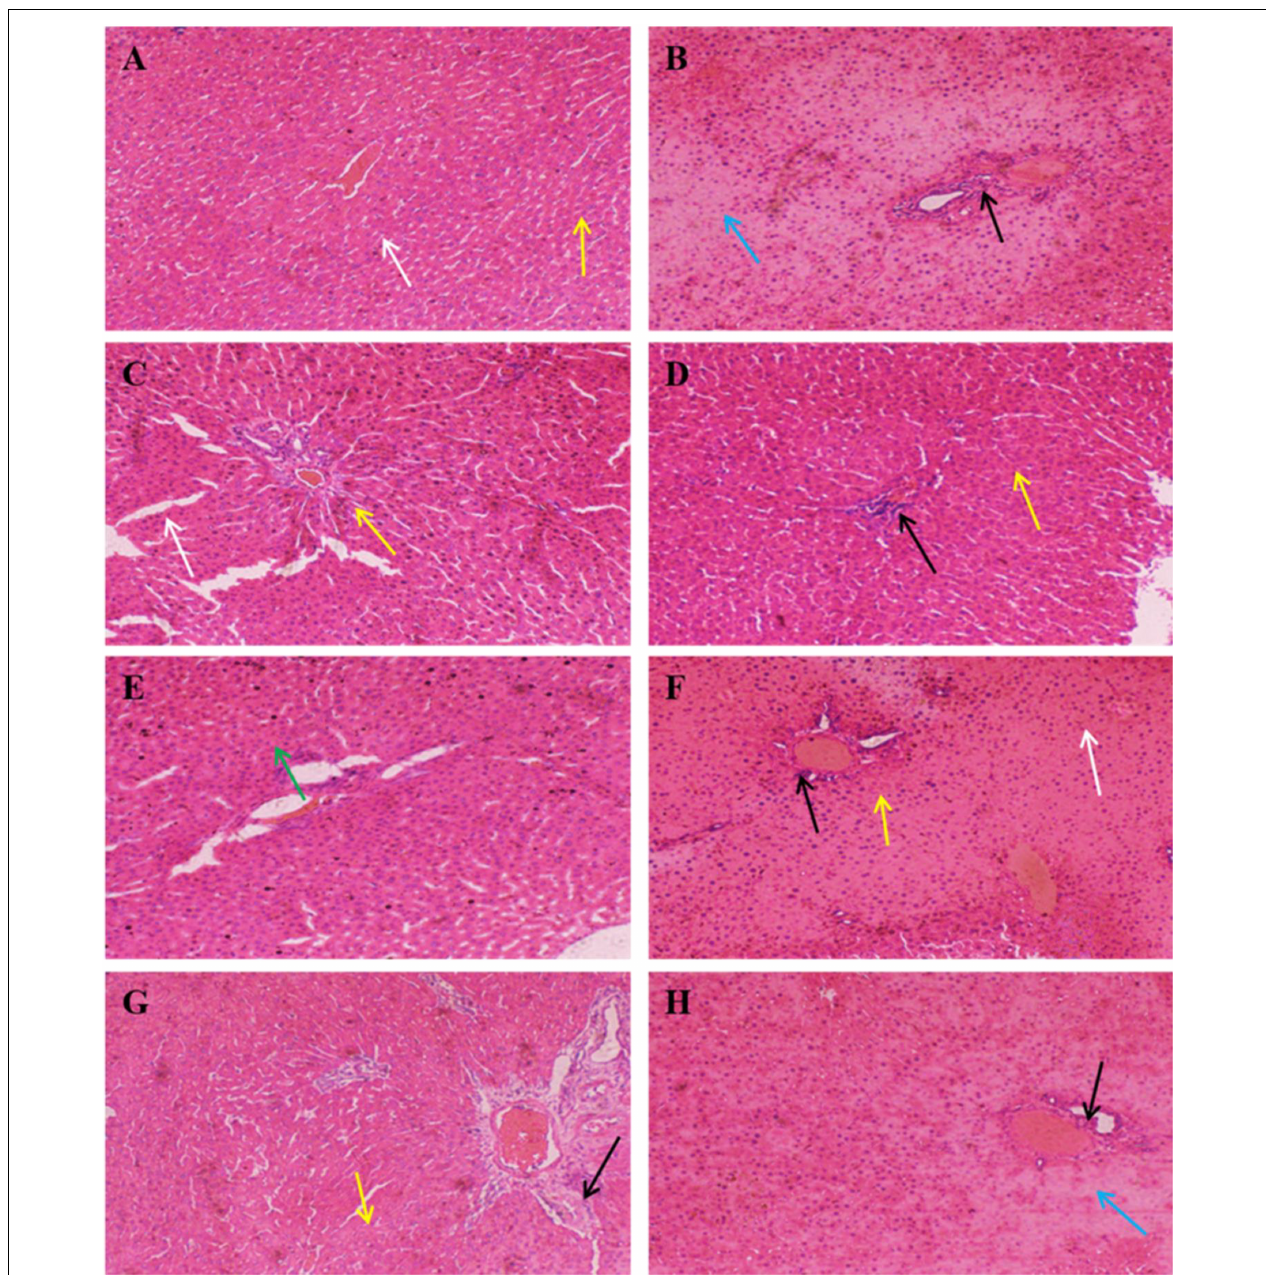
FIGURE 5 | Histopathology of liver (H&E, × 100). Yellow arrows indicate hepatic sinusoids; blue arrows indicate necrosis of hepatocytes and disappearance of nuclei consolidation and lysis; white arrows indicate hepatic sinusoidal macrophages; black arrows indicate inflammatory cells; green arrows indicate neoplastic cells. (A) Control group, (B) Model group, (C) PC group, (D) SePro group, (E) SePPs group, (F) PPs group, (G) SeMet group, (H) Na 2 SeO 3